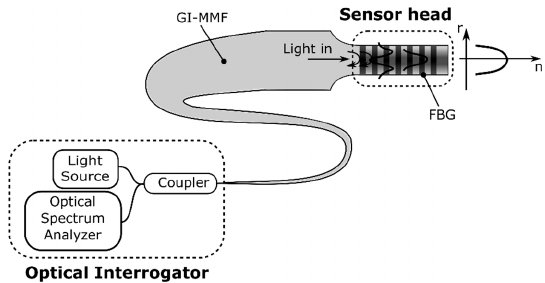
Figure 1. Schematic of the experimental setup for the etched OM4 Graded-Index Multi Mode Fiber (GI-MMF) with Bragg Grating (BG) for simultaneous measurement of Surrounding Refractive Index (SRI) and temperature using Principle Mode Group (PMG) multiplexing. The inset figure visualizes the general refractive index (n) distribution of a GI-MMF as a function of the fiber core radius